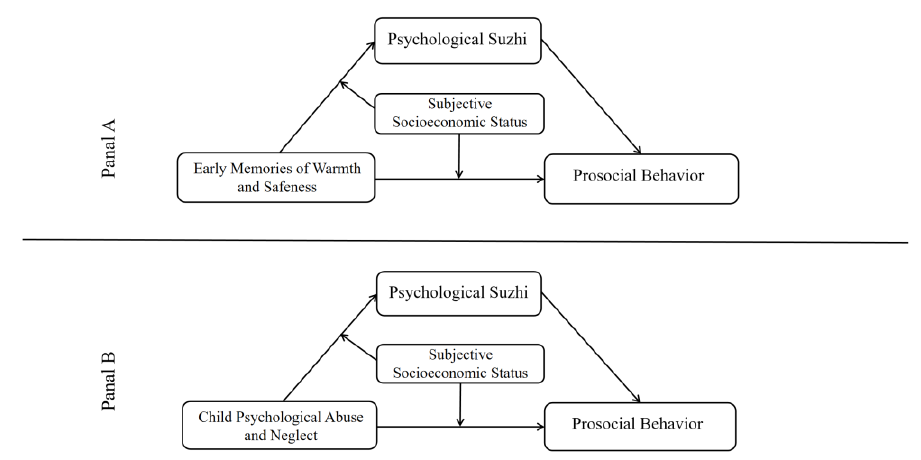
Figure 1. The moderated mediation models.